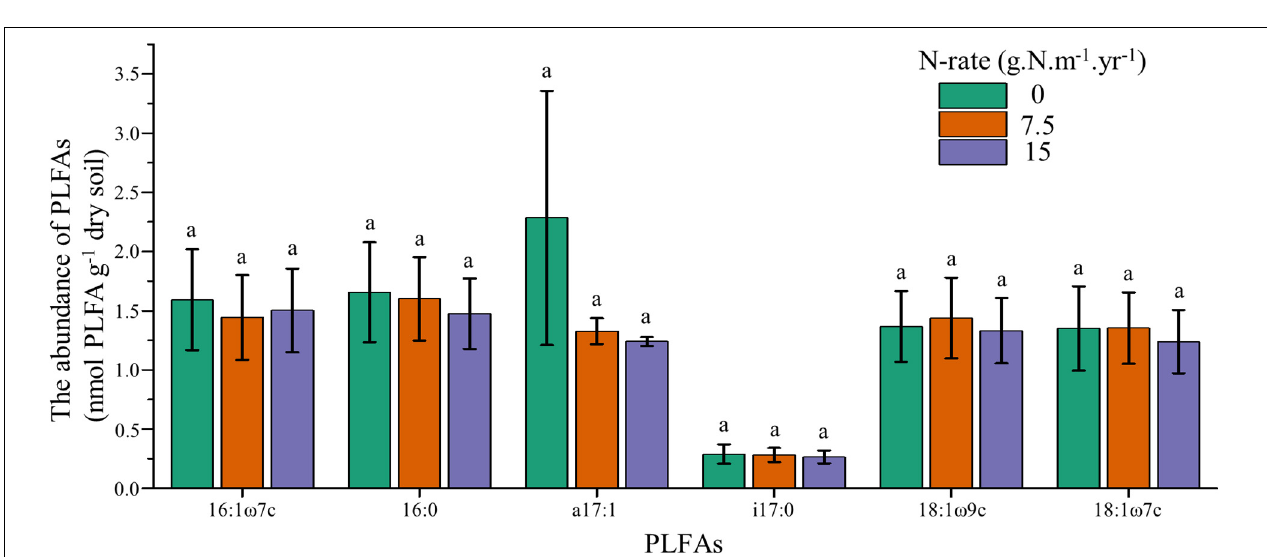
FIGURE 2 | Changes of core microbes under different N application rates. Treatments are expressed by data with means ± SE ( n = 4). Different letters above boxes indicate significant differences between N application rates at the P < 0.05 level.